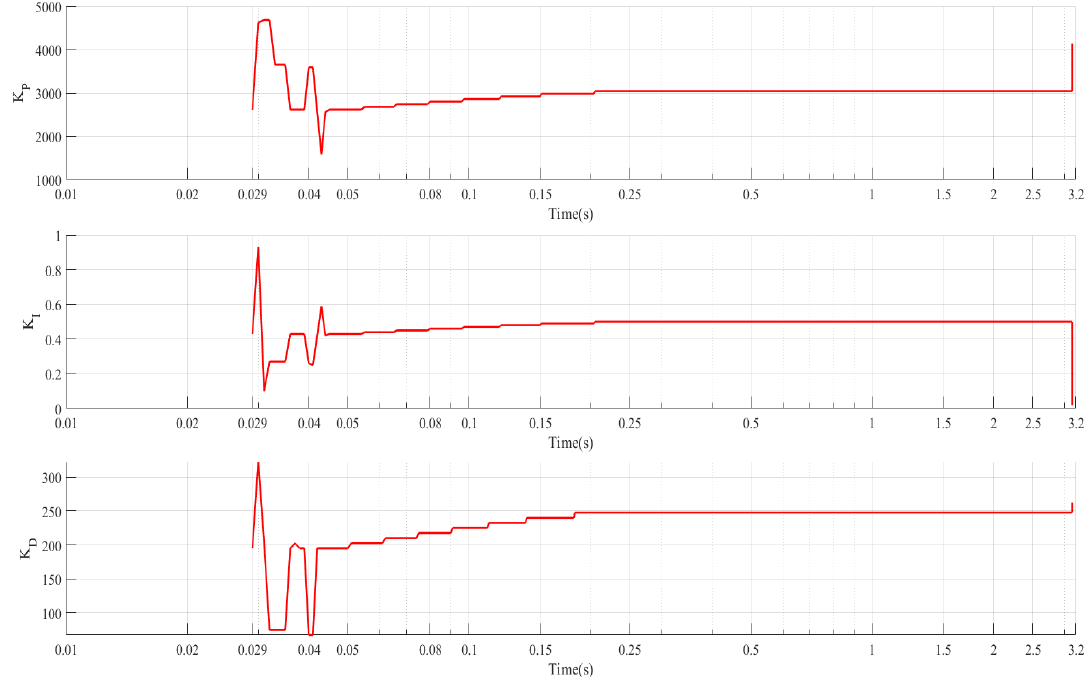
Figure 11. Fuzzy-PID control output parameters: K P , K I and K D with adaptive